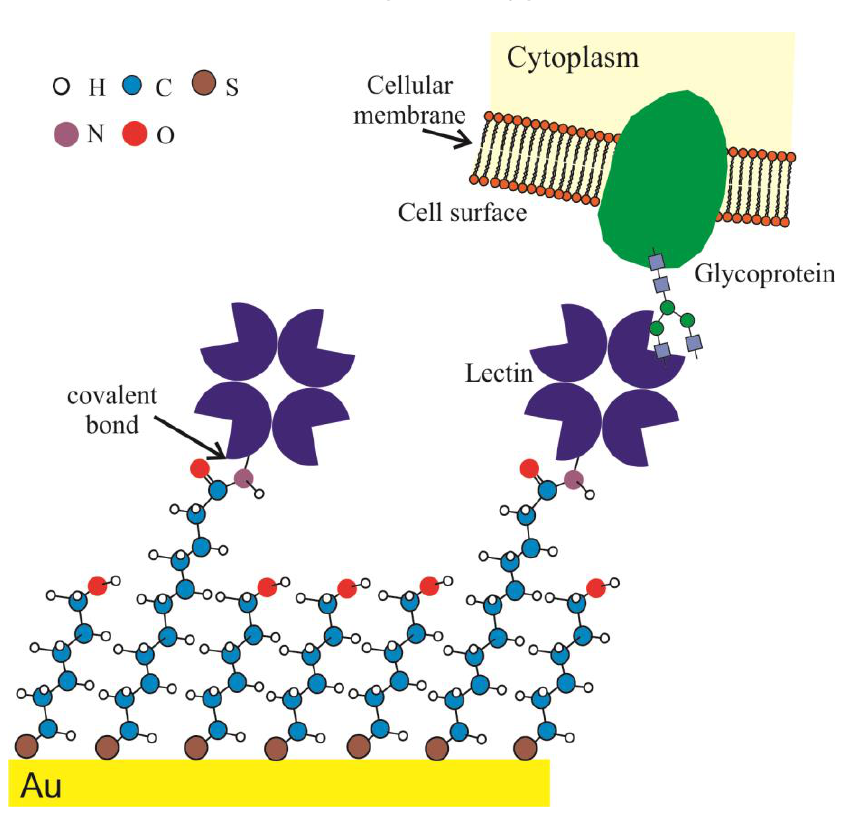
Figure 1. Schematic representation of functional SAM used to characterize ArtinM–cell binding by EIS and QCM. The surface was constructed onto a gold surface using mixed thiol–SAM structures, in which 11-mercaptoundecanoic acid served as a receptor-supportive layer for lectin attachment, and 6-mercaptohexanol served as a spacer layer. ArtinM immobilization was achieved through standard EDC/NHS bioconjugation, and the nonspecific sites were blocked with gelatin (not shown). NB4 cells at various concentrations were quiescently lying on the interface for EIS or were injected in flux for QCM. The schematic illustrates only one carbohydrate recognition domain of ArtinM interacting with only one N-glycan, the glycoprotein of the cell surface. Indeed, many N-glycans on glycoproteins of cell surface could be recognized by all carbohydrate recognition domains of